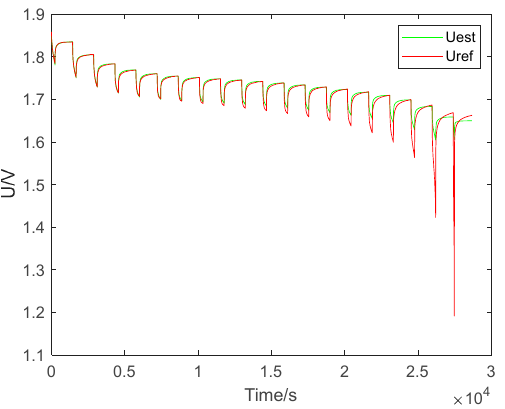
Figure 7. Comparison of the voltage prediction curves.